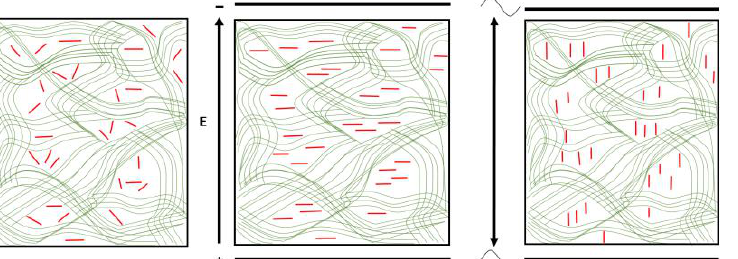
Figure 6. Imaginary picture of the composite agarose gel with incorporated PM, which are shown schematically as rods (diametrical cross section of the membrane plane) oriented chaotically (the left picture), perpendicularly to the direct electric field (the medium picture) and along the field direction in the kilohertz sinusoidal electric field (the right picture).